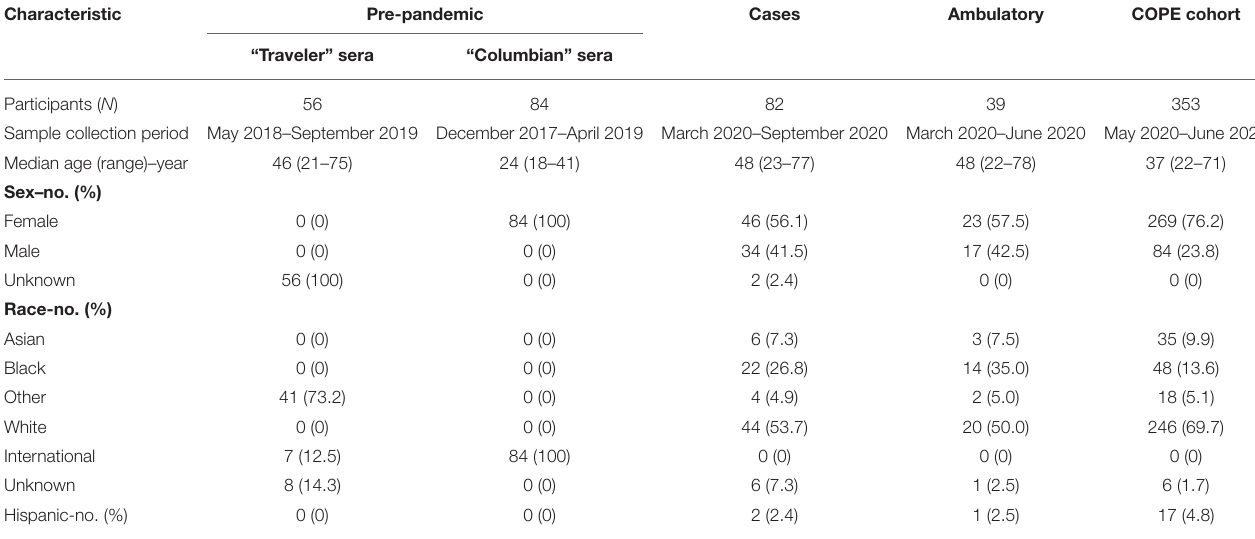
TABLE 1 | Characteristics of study